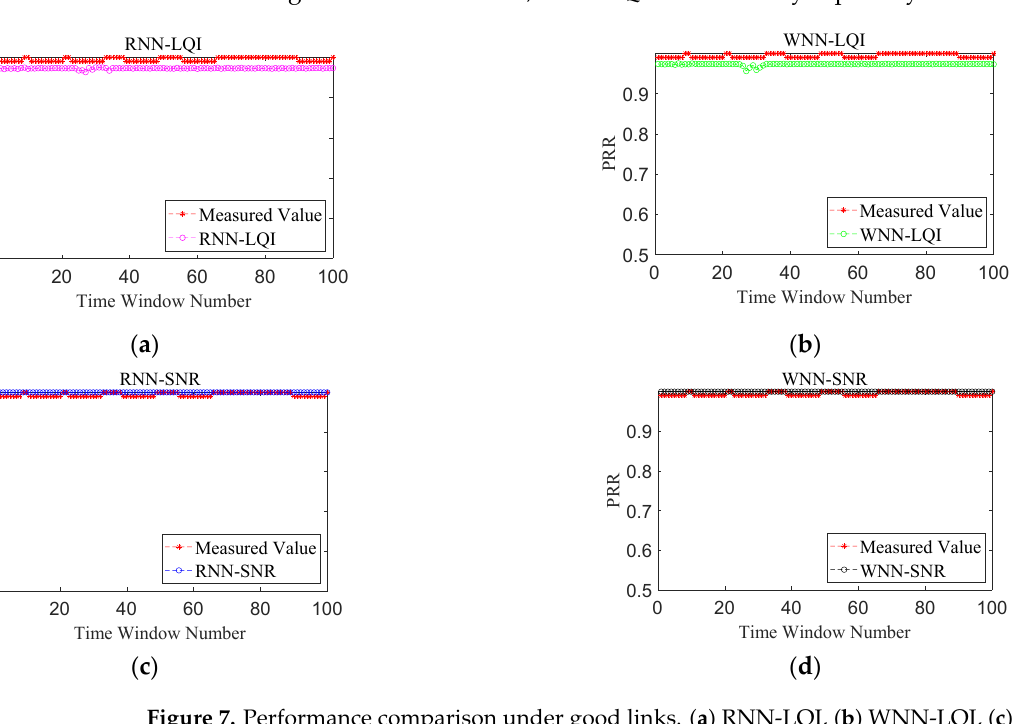
Figure 7. Performance comparison under good links. ( a ) RNN-LQI, ( b ) WNN-LQI, ( c ) RNN-SNR,